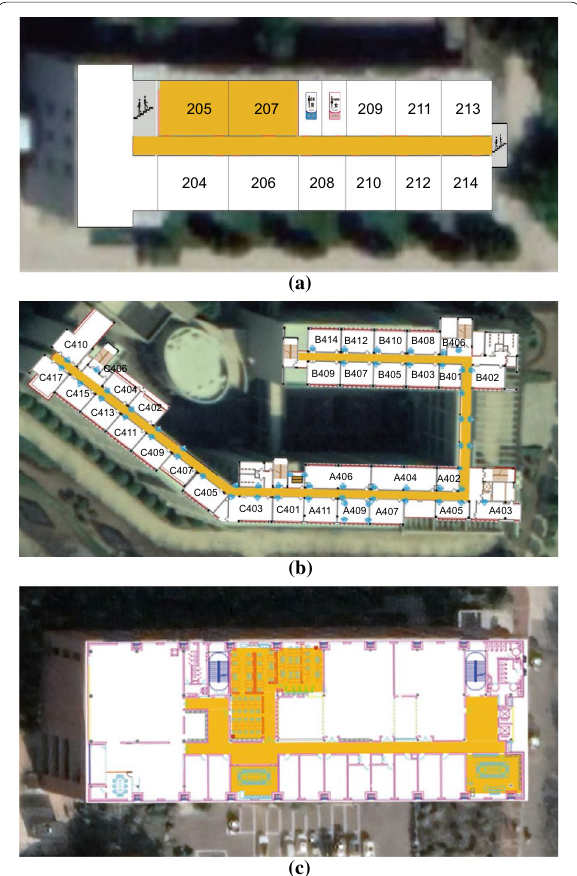
Fig. 1 The testing area covers three buildings, a CETC331 building with the 2nd floor, b HCXY building, and c SYL building with the 4th